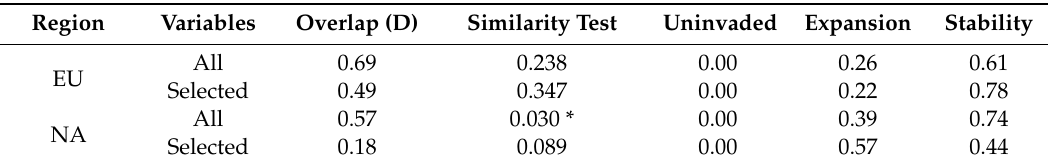
Table 5. Summary of p values for the niche test of Dutch elm disease between native range Asia and invasive ranges Europe (EU) and North America (NA) using all and selected climatic variables. Significant p -values ( α = 0.05) are represented by *.